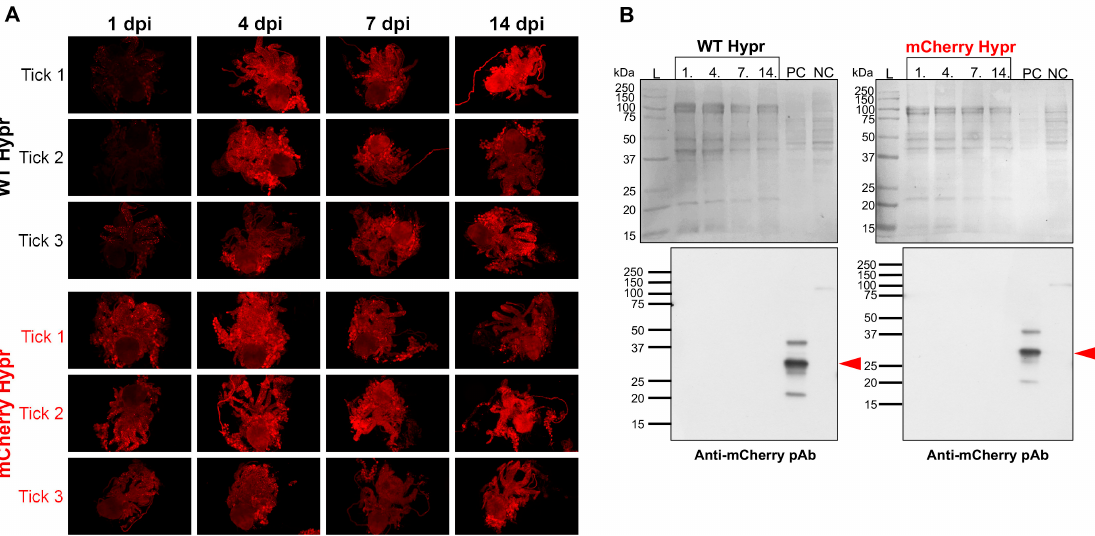
Figure 5. Detection of reporter mCherry Hypr in ticks. ( A ) Whole-mount immunofluorescence of mCherry Hypr with representative images showing internal organs of ticks (n = 3) dissected at 1, 4, 7, and 14 days post-infection (dpi) labeled with anti-mCherry primary antibody and Alexa Fluor 596-conjugated secondary antibody. WT Hypr ticks infected with wild-type Hypr TBEV and mCherry Hypr ticks infected with mCherry Hypr TBEV are shown. ( B ) Western blot in unfed ticks. Upper panels show PVDF membrane with Ponceau S-stained total protein of unfed I. ricinus nymphs (4/lane) infected with wild-type Hypr TBEV (WT Hypr) and mCherry Hypr TBEV and sampled at 1, 4, 7, and 14 dpi. The L-protein ladder is shown. The PC-positive control, lysate of mCherry Hypr-infected BHK-21 cells, and the NC-negative control, lysate of noninfected BHK-21 cells, are shown on the right sides of the upper panels. Lower panels indicate immunobloting after probing with an anti-mCherry polyclonal antibody. Arrowheads denote a specific antibody response to the mCherry